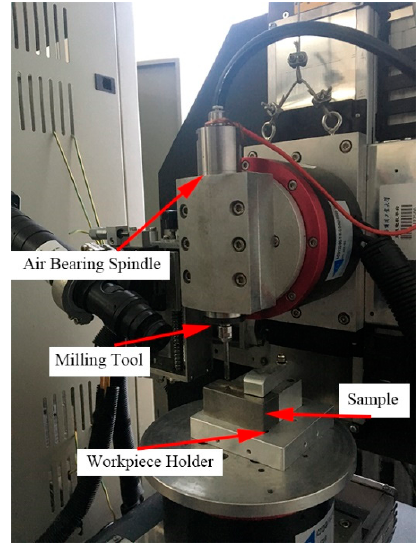
Figure 6. The experimental facility for milling titanium alloy samples.